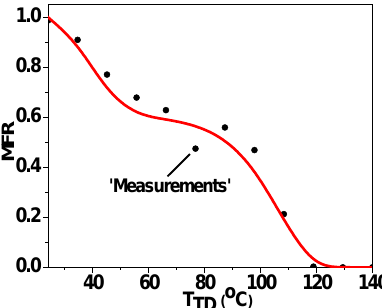
Figure 1. Predicted thermograms (MFR versus T TD ) for OA with different properties. A single component aerosol (C * =1 μg m -3 , ΔH vap =80 kJ mol -1 and a m =0.05) gives practically the same thermogram as one with a much lower volatility (C * =0.01 μg m -3 , ΔH vap =100 kJ mol -1 and a m =1).